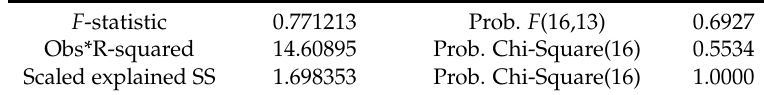
Table 7. Heteroskedasticity Test: